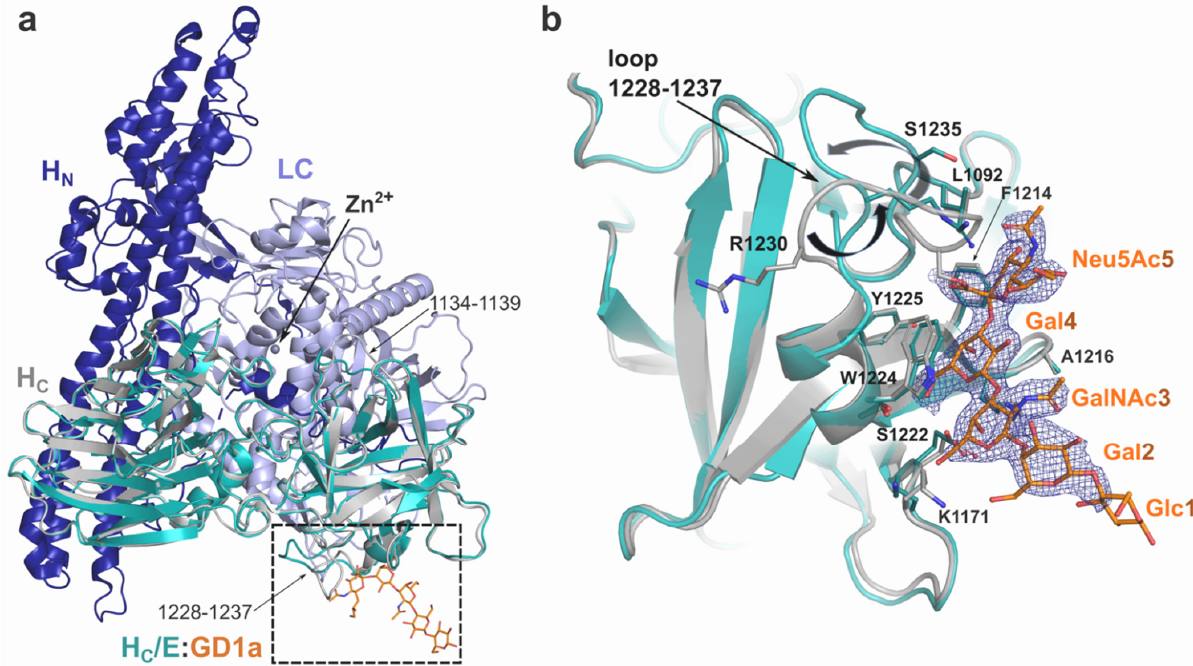
Figure 1. Structure of BoNT/E. ( a ) Superposition of the H C /E:GD1a complex structure with full-length BoNT/E (PDB 3FFZ [22] ). Domain organisation of BoNT/E is highlighted with the light chain (LC) in light blue, translocation domain (H N ) in blue and the binding domain (H C ) in grey. H C /E from the complex structure is shown in teal with the GD1a-oligosaccharide in orange. ( b ) Close-up view of the ganglioside binding site. Electron density around GD1a is shown as a blue mesh (2 Fo - Fc map at 1.5 σ ). Movement of loop 1228–1237 is represented by black arrows. Table 1. Crystallographic Data Collection and Refinement.